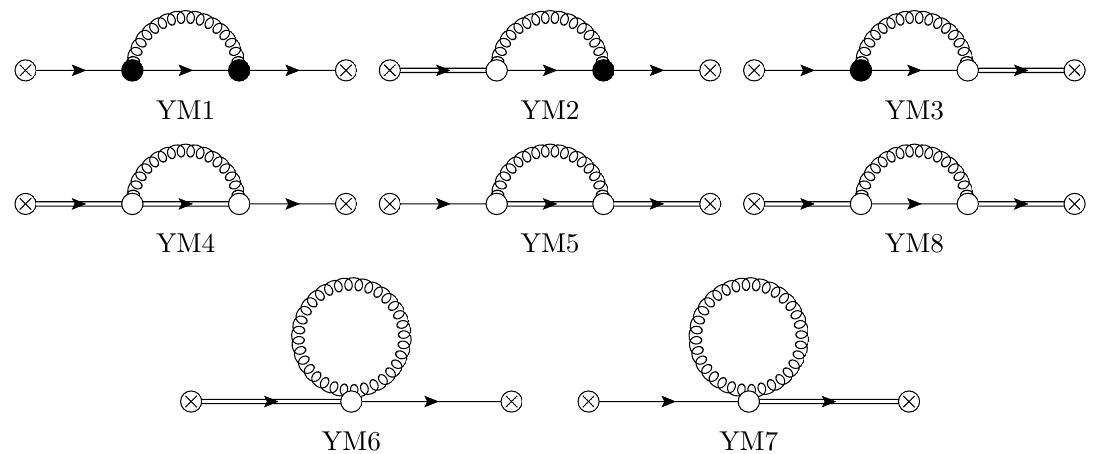
Figure 10. Next-to-leading order diagrams for the YMGF evolved fermion 2-point function. White blobs represent GF vertices, black blobs the usual QCD vertices, and double lines indicate a kernel including integration over the associated flow time.